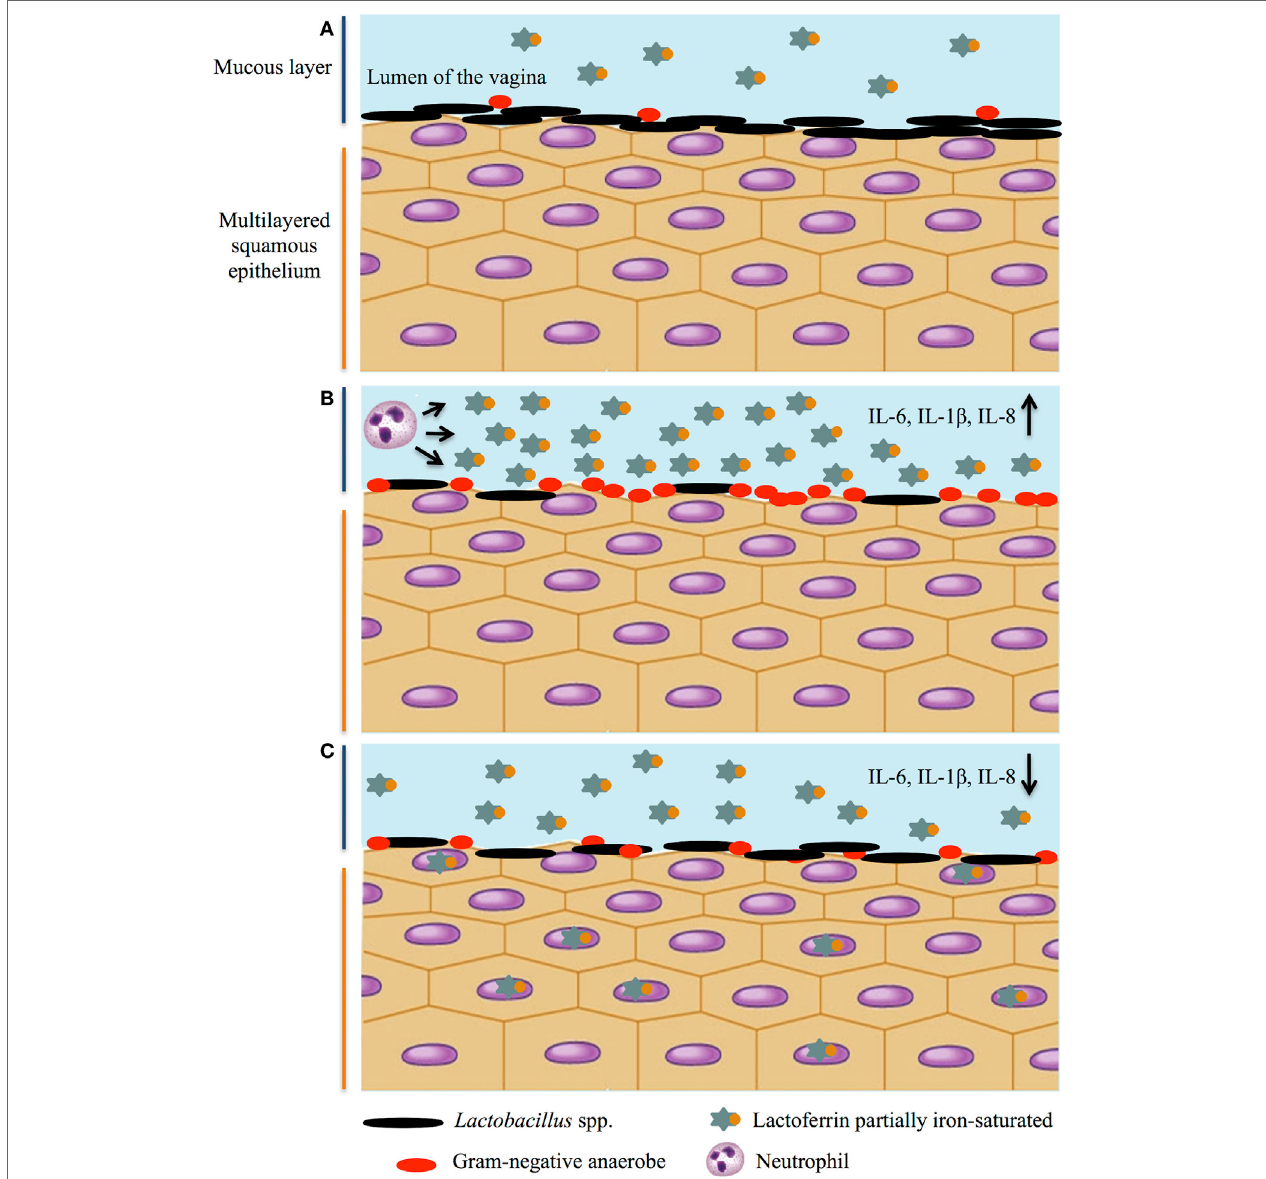
FiGURe 2 | Lactobacillus spp. and lactoferrin interplay on infection and inflammation in female genital tract. A schematic representation of Lactobacillus spp. and lactoferrin balance: a multitasking strategy to protect against pathogen challenge and maintain immune homeostasis. (a) Healthy genital tract; (b) vaginosis: high levels of pro-inflammatory cytokines, decrease of lactobacilli and increase of Gram-negative anaerobes, and increase of lactoferrin concentration released by neutrophils; (C) decrease of pro-inflammatory cytokines by lactoferrin and restoration of healthy